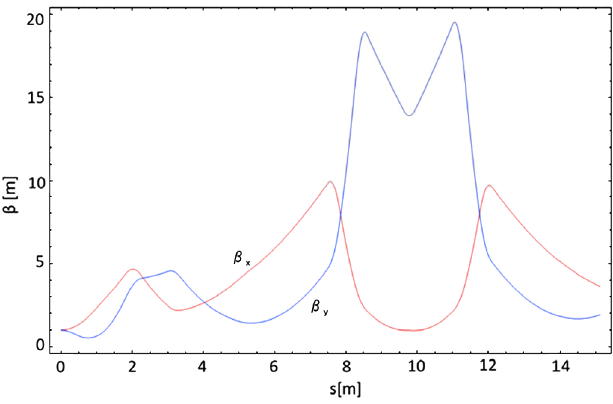
FIG. 11. Beta functions in the x and y directions.